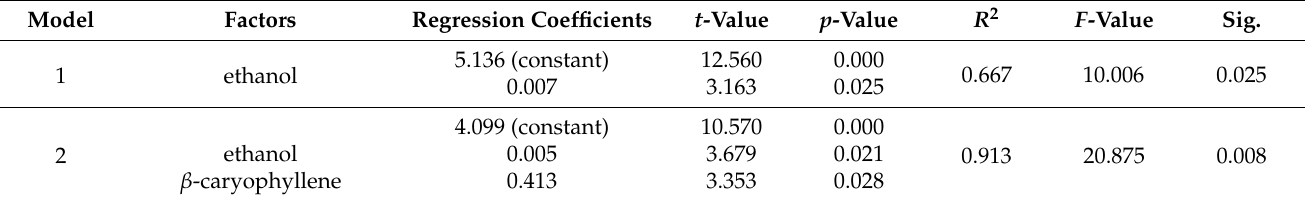
Table 4. Stepwise multiple regression analysis on the key factors of volatile compounds with OAV ≥ 1 significantly influencing aroma flavors of the fermented orange juices and original orange juice